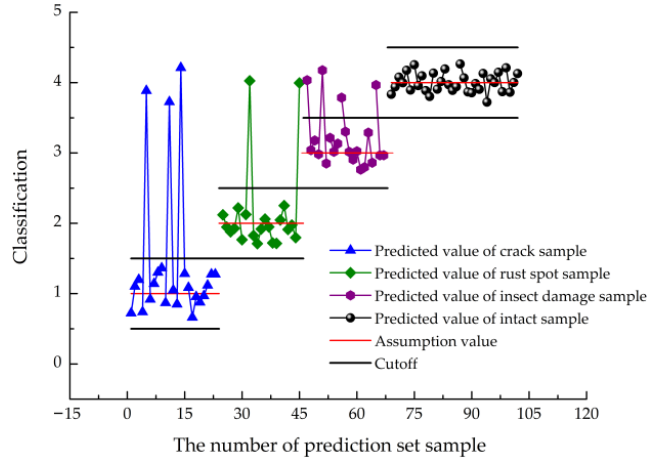
Figure 7. The discriminant result of the CARS-LS-SVM model.